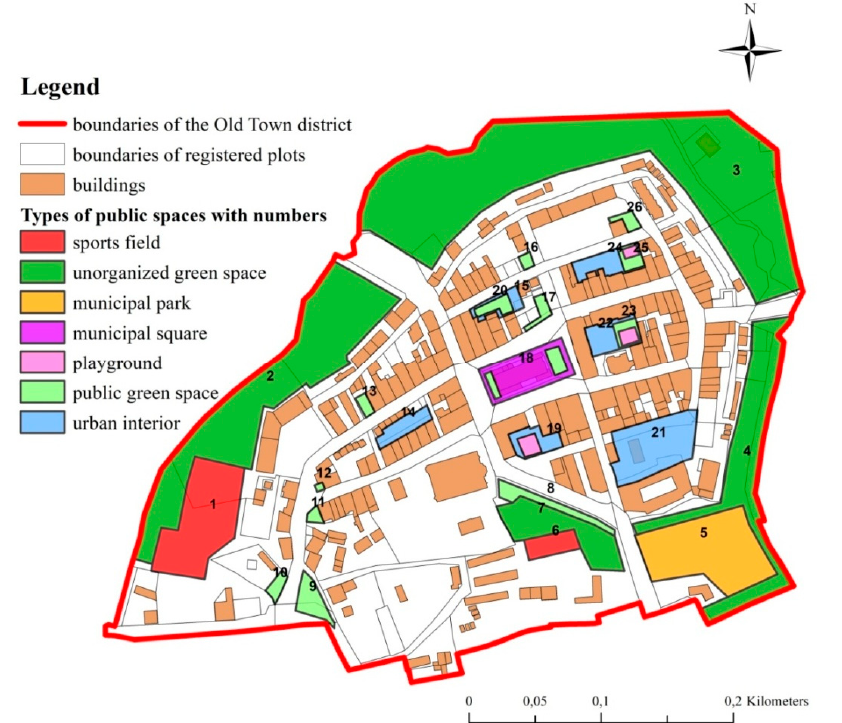
Figure 4. Distribution of public spaces in the center of Orneta. Source: own elaboration. Description of public spaces: 1. Sports field, 2. Unorganized green space, 3. Unorganized green space, 4. Unorganized green space, 5. Municipal park (under construction)/green space, 6. Sports field, 7. Unorganized green space, 8. Public green space, 9. Public green space, 10. Public green space, 11. Public green space, 12. Public green space, 13. Public green space, 14. Urban interior, 15. Urban interior, 16. Public green space, 17. Public green space, 18. Municipal square with public green space, 19. Urban interior with playground, 20. Public green space, 21. Urban interior, 22. Urban interior, 23. Playground with public green space, 24. Urban interior, 25. Playground with public green space, 26. Public green space.